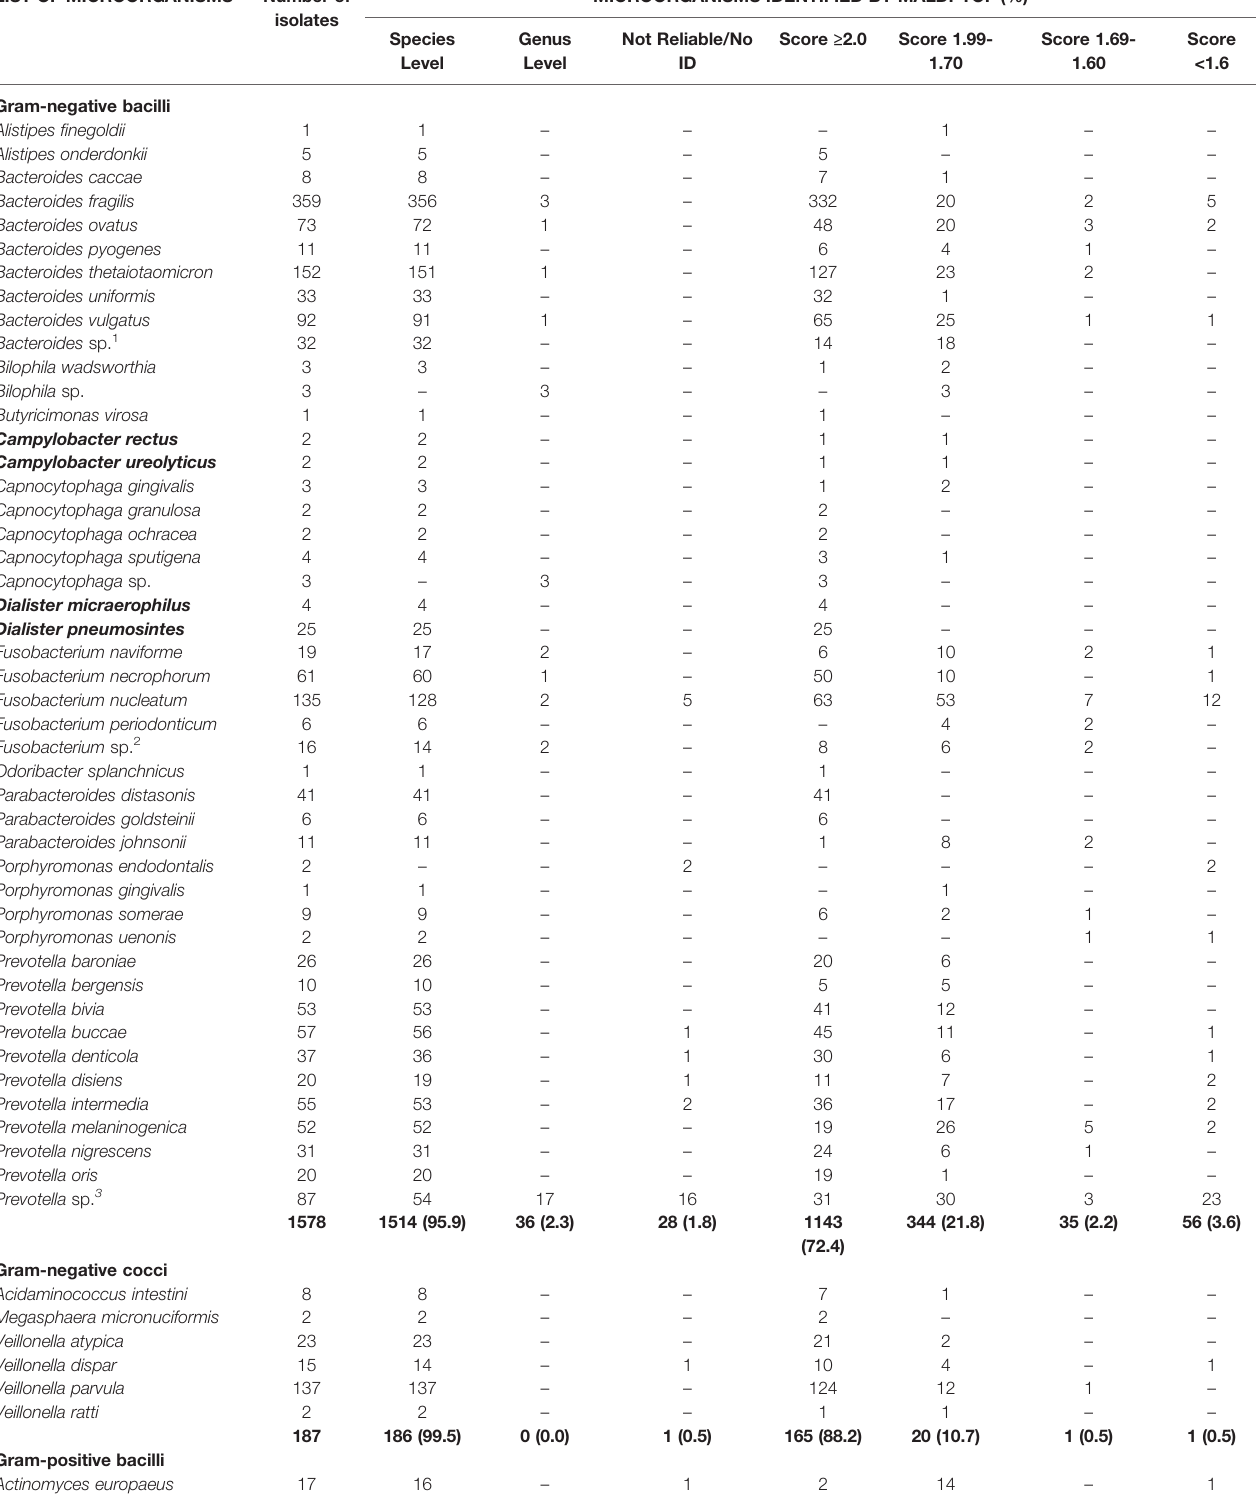
TABLE 1 | List of anaerobic isolates identi fi ed by MALDI-TOF